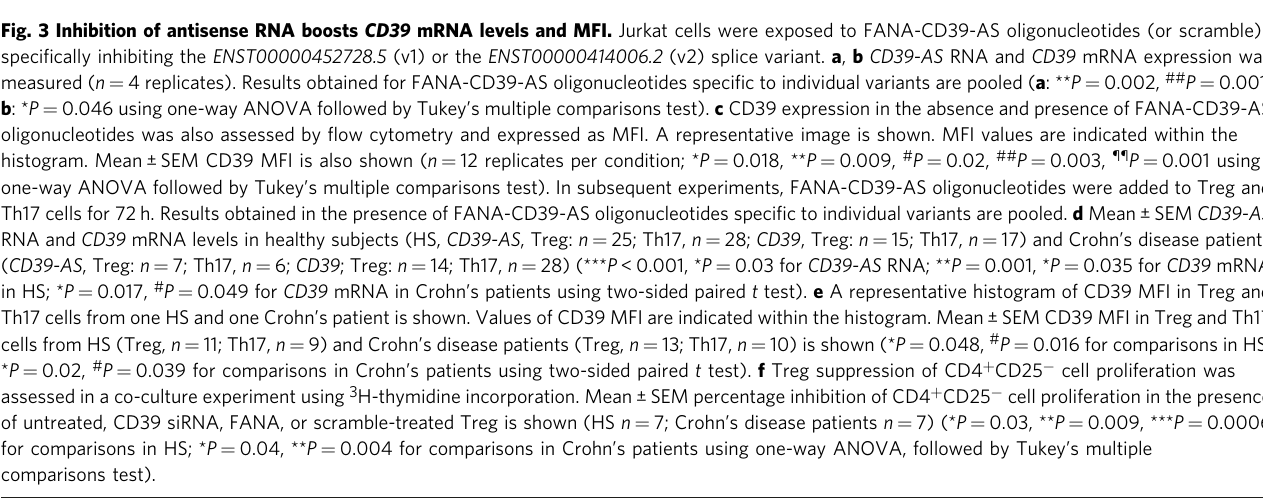
(Fig. 6d) of Crohn ’ s disease patients. No signi fi cant changes were observed in CD39 mRNA levels and MFI following NCL and HNRNPA1 silencing in Treg and Th17 cells obtained from healthy subjects (Fig. 6c, d) and in the levels of CD39-AS RNA in Treg and Th17 cells from both Crohn ’ s disease patients and healthy subjects (Fig. 6c, d).